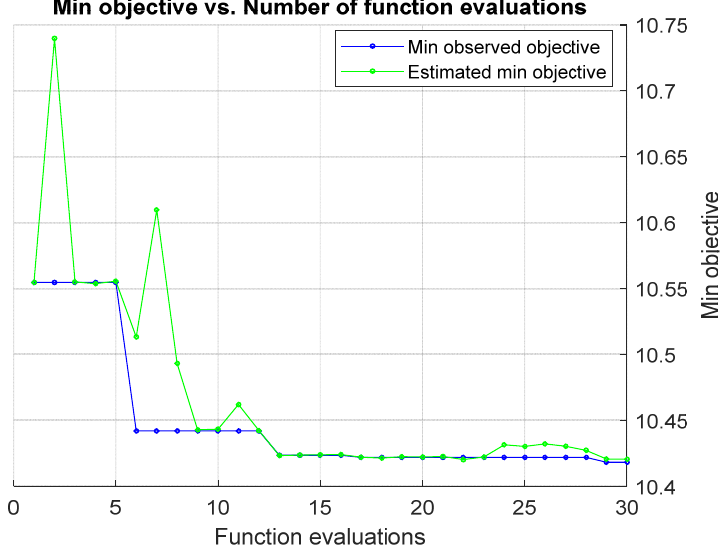
Figure 6. Minimum objective versus function evaluation pattern with Bayesian search.